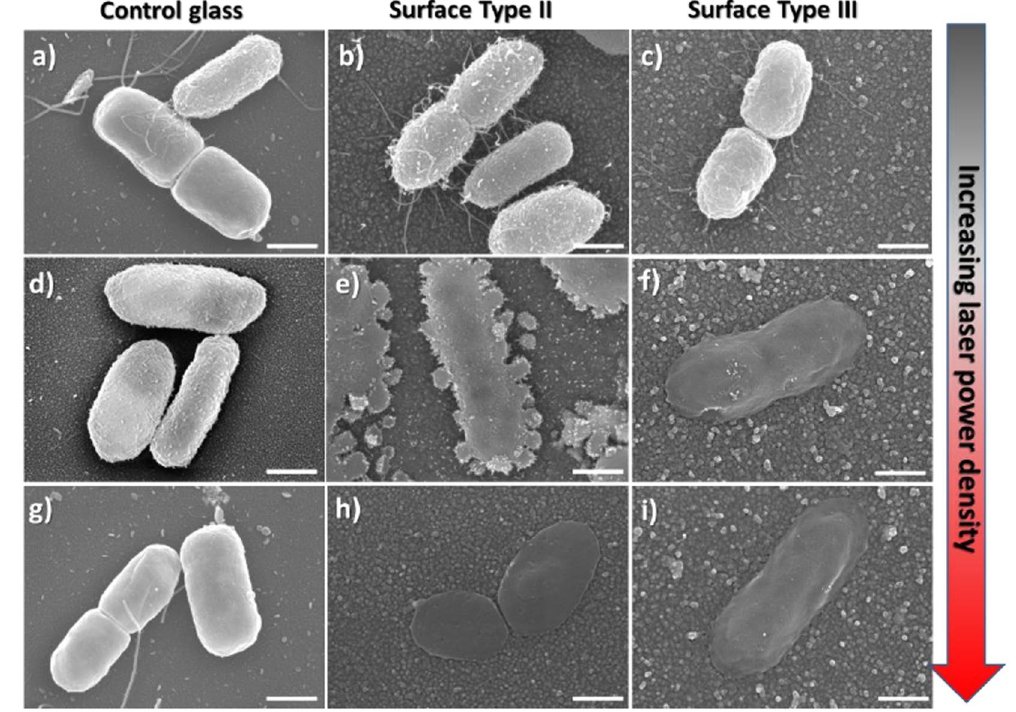
Figure 5. Representative SEM images showing the effect of laser irradiation on E . coli cells attached to: (by column) ( a , d , g ) Control glass; ( b , e , h ) Type II surfaces (glass|GNS|SiO 2 ); ( c , f , i ) Type III surfaces (glass|GNS|SiO 2 |AgNP). Increasing power density (by row): ( a , b , c ) = non irradiated samples; ( d , e , f ) = samples irradiated with 5 × objective lens; ( g , h , i ) = 20 × objective lens. All scale bars are 500 nm. Large area SEM images are shown in ESI (SI14 and